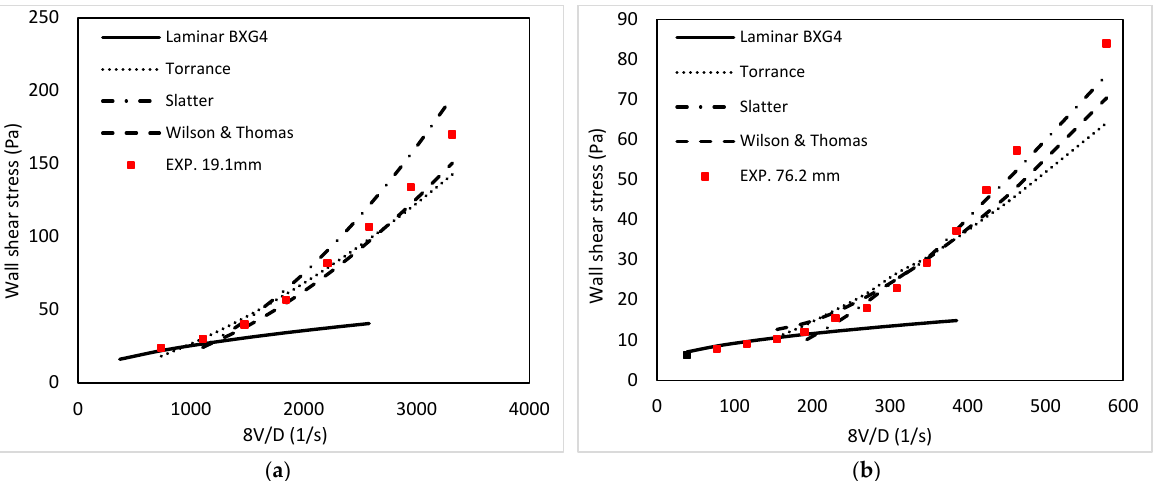
Figure 11. Comparison between predicted and experimental data of turbulent fl ow for BXG4 Herschel–Bulkley fl uids: ( a ) pipe diameter 19.1 mm, ( b ) pipe diameter 76.2 mm.